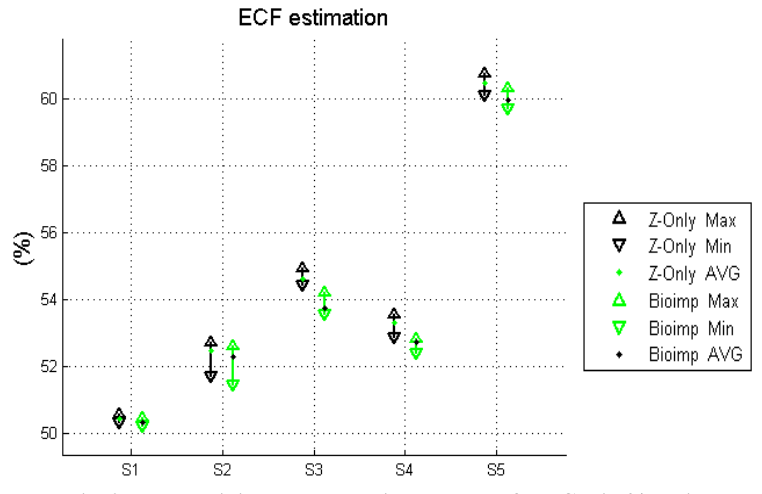
Fig. 3: Mean, minimum and maximum values for ECF, in %, estimated for all the subjects with both methods